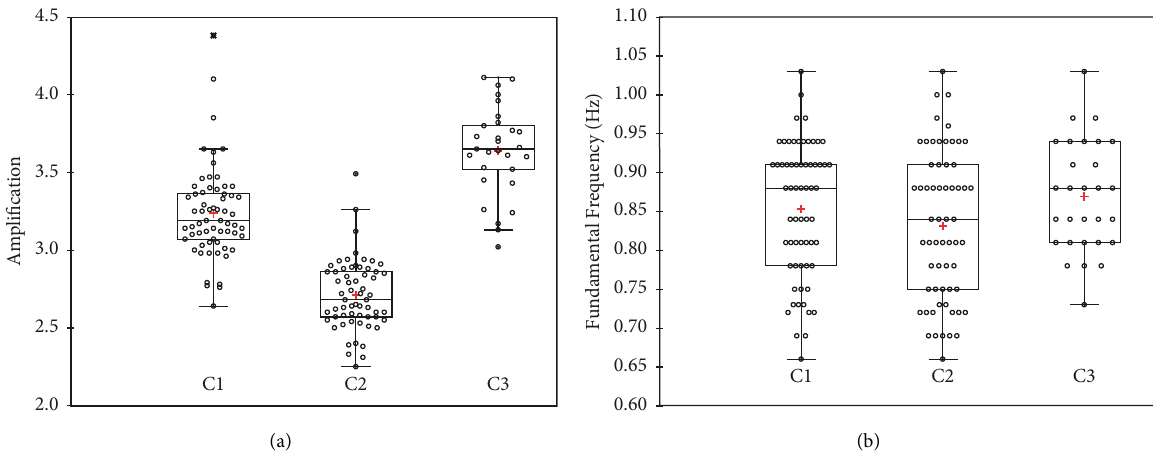
Figure 7: Box-plots showing the distribution of variables: (a) Amplitude (Ao) and (b) Frequency (fo), by FCM clustering technique.